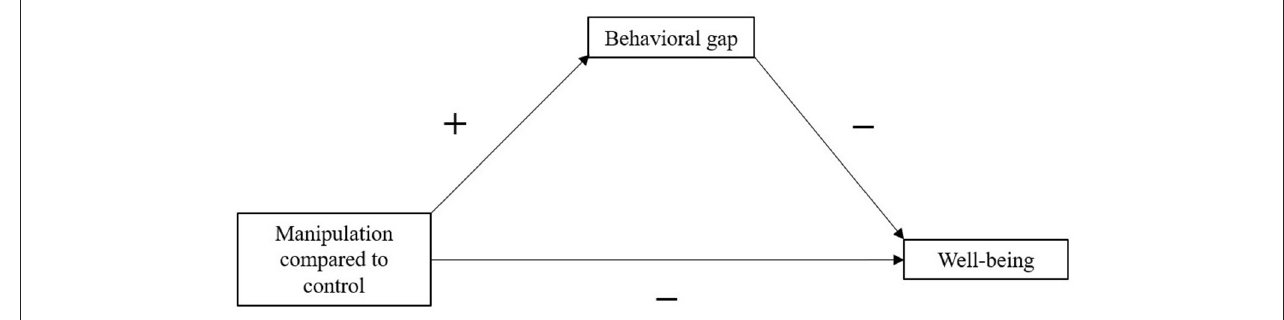
FIGURE 1 | Proposed mediation model of the relationships between manipulations, behavioral gap, and measures of well-being.